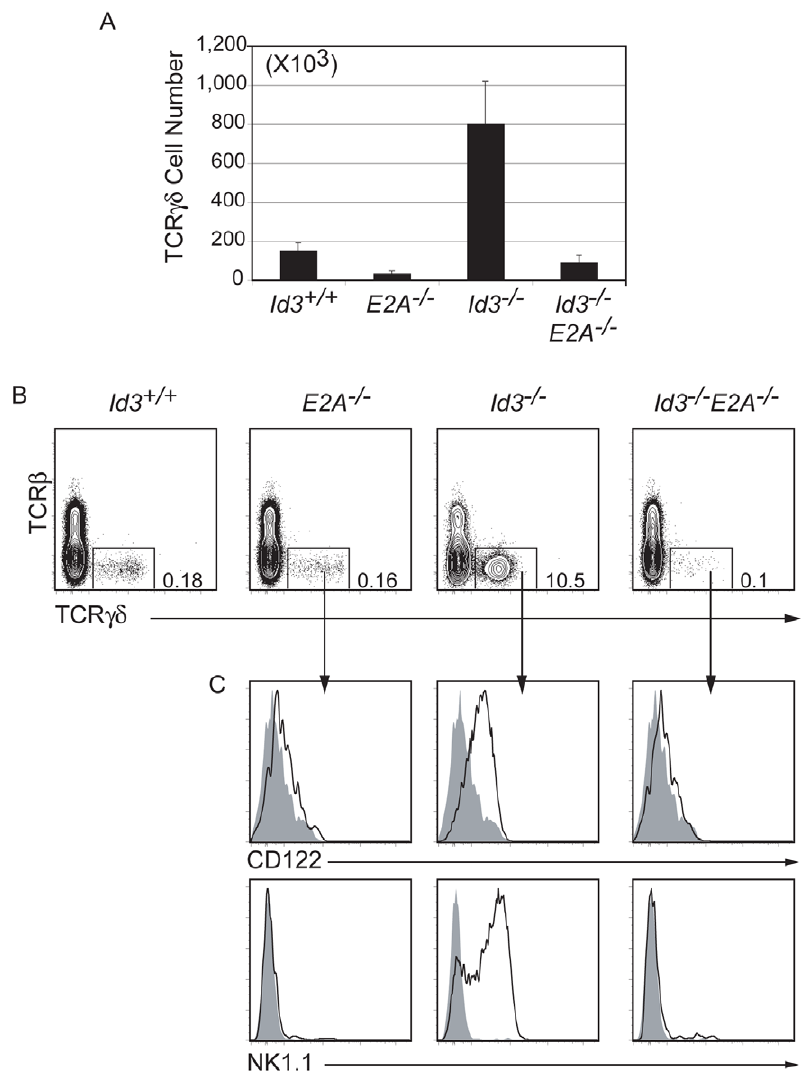
Figure 7. cd T cell development in Id3 2 / 2 mice is E2A dependent. A) Total number of TCR cd + cells in the thymus of Id3 + / + , E2A 2 / 2 , Id3 2 / 2 and Id3 2 / 2 E47 2 / 2 mice. Bars represent the average + / 2 standard deviation. p , 0.001 for Id3 2 / 2 compared to all other genotypes. B) Flow cytometric analysis for TCR b and TCR cd in mice with the indicated genotype. The frequency of TCR cd + cells is shown. (C) Analysis of TCR cd + cells for CD122 (upper plots) and NK1.1 (lower plots) expression. Genotypes are as indicated in (C) (for the open histogram) and are shown relative to Id3 + / + TCR cd + cells (shaded histogram), which served as a negative control. Results are representative from at least 6 mice of each genotype.